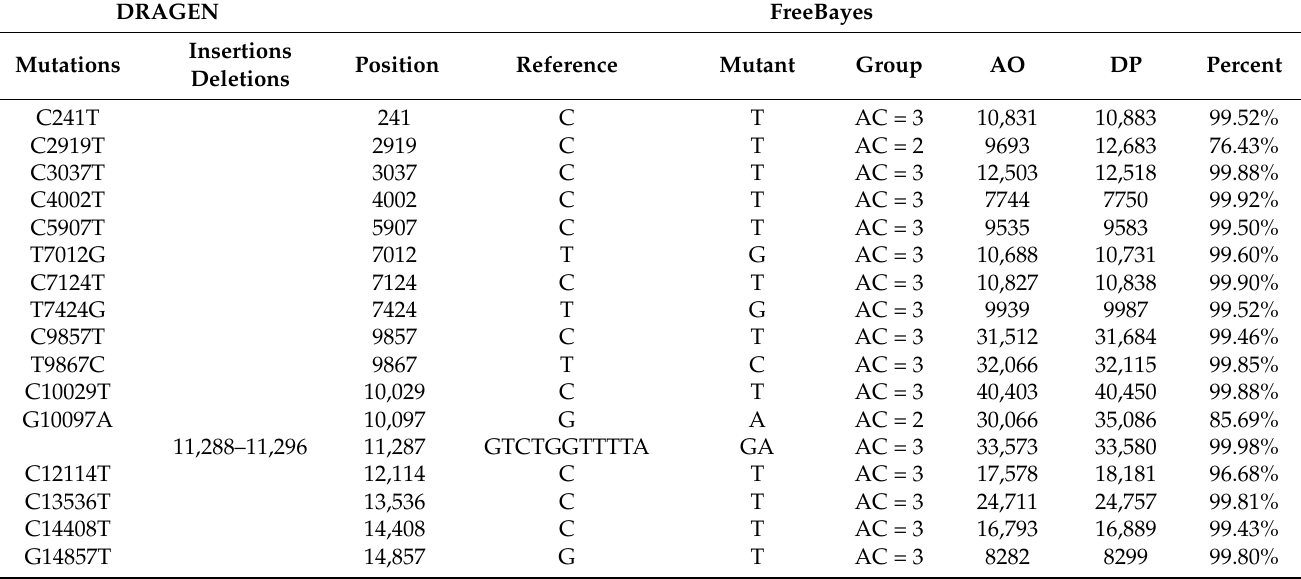
Table 3. Mutations present in sample